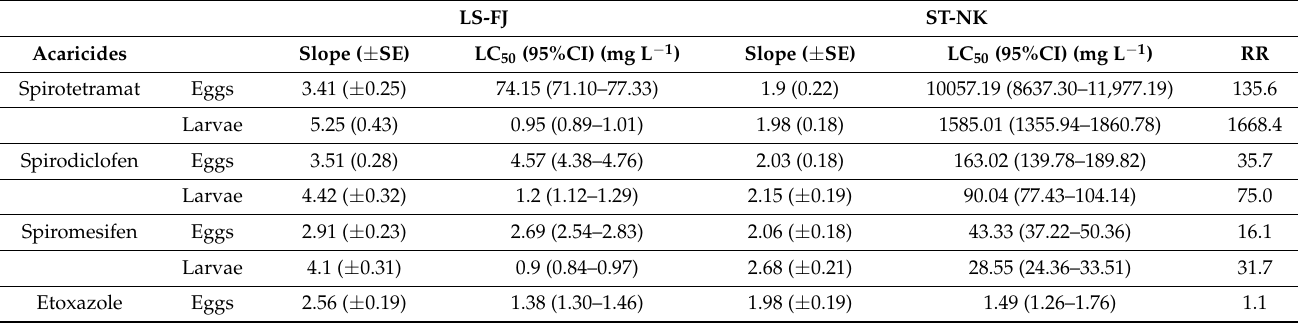
Table 1. Concentration probit-mortality data of different acaricides on larvae of the LS-FJ and ST-NK strains with calculated resistance ratios (RRs).